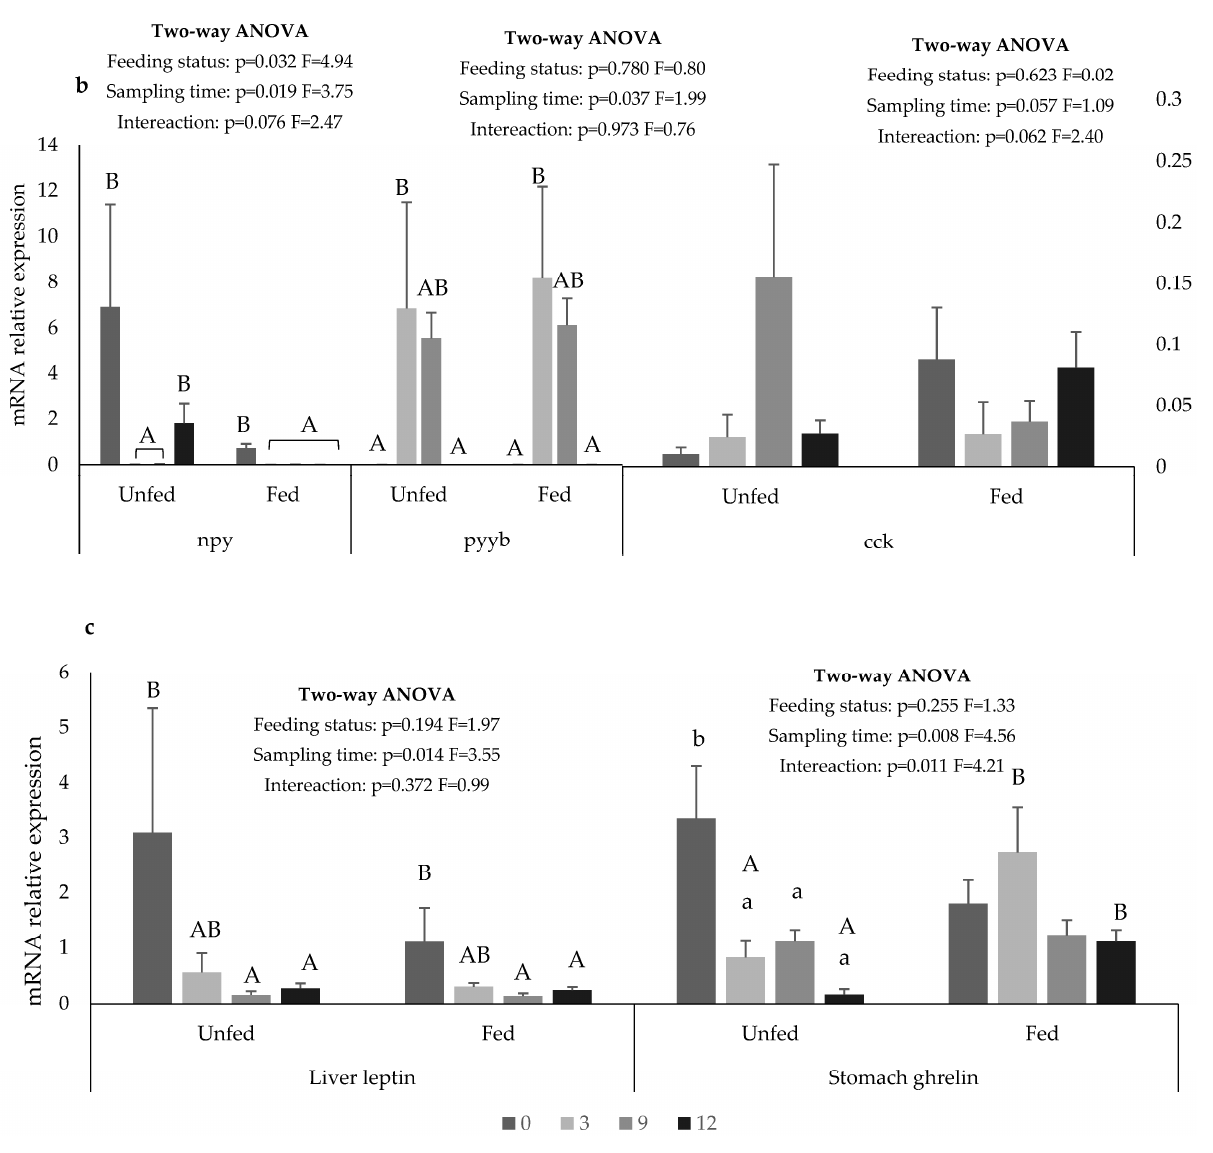
Figure 4. mRNA relative expression of main hormones and peptides in the peripheral systems anterior intestine ( a ), posterior intestine ( b ), liver and stomach ( c ) of European seabass days after feed deprivation (unfed) or continuous feeding (fed). Data were normalized with two housekeeping genes, ribosomal 18S (18S) and α‐ elongation factor (ef1), according to [56]. Values are presented as means and standard error (SE). Small letters denote significant differences in sampling time under the same feeding conditions and capital letters denote significant differences in sampling times regardless of feeding conditions. npy: neuropeptide Y; pyyb: peptide YYb; cck: cholecystokinin; lep: leptin; ghr: ghrelin.